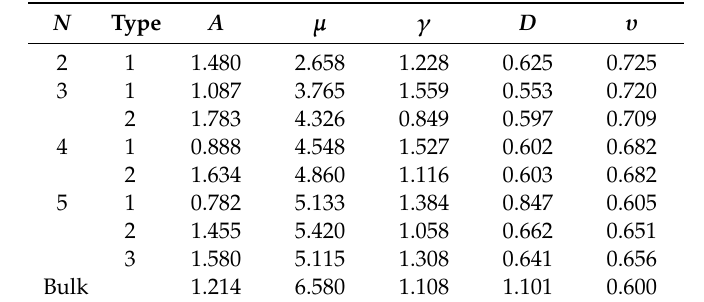
Table 3. Critical parameters of the asymptotic formulas (Equations (1) and (2)) as obtained from non-linear fits on the SAW data presented in Figures 6 and 9 for the confined BCC lattice. Also shown for comparison are the results for the bulk (unrestricted) case.